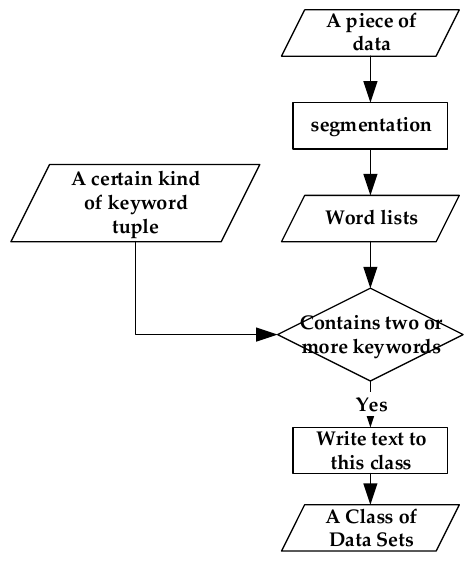
Figure 4. Pre-classification process.